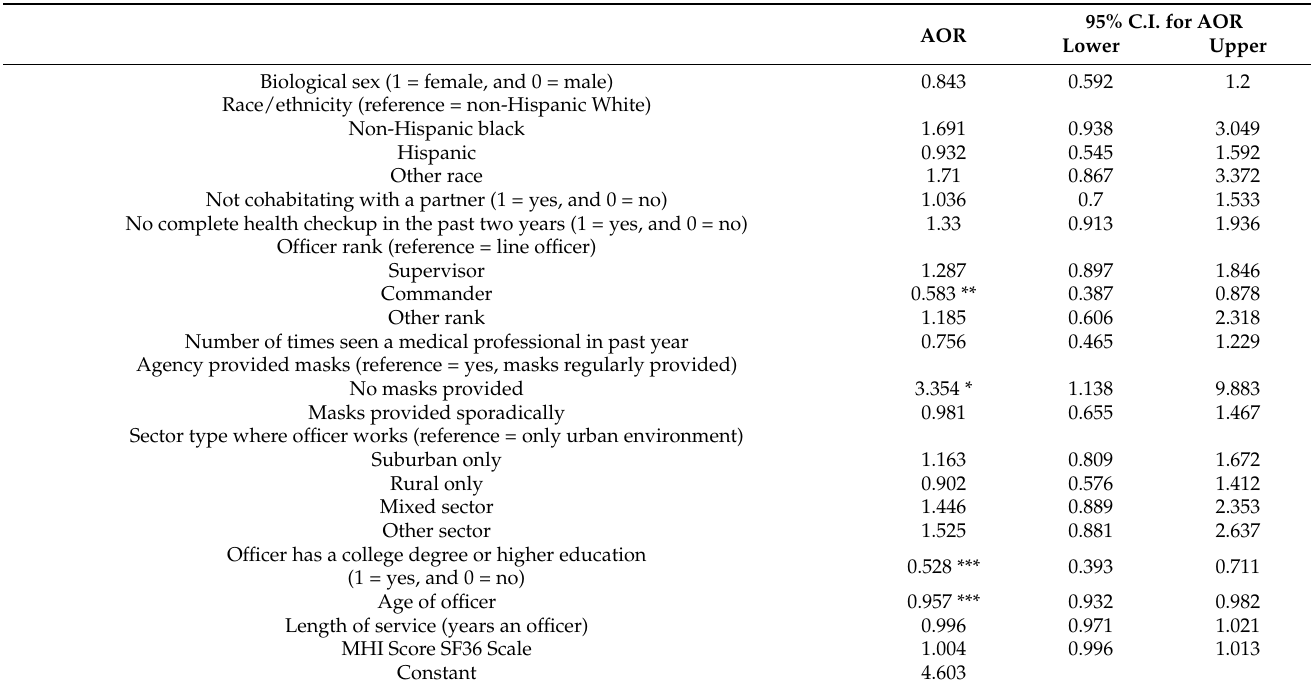
Table 3. Logistic regression for COVID-19 vaccine hesitancy ( n = 997 after accounting for missing